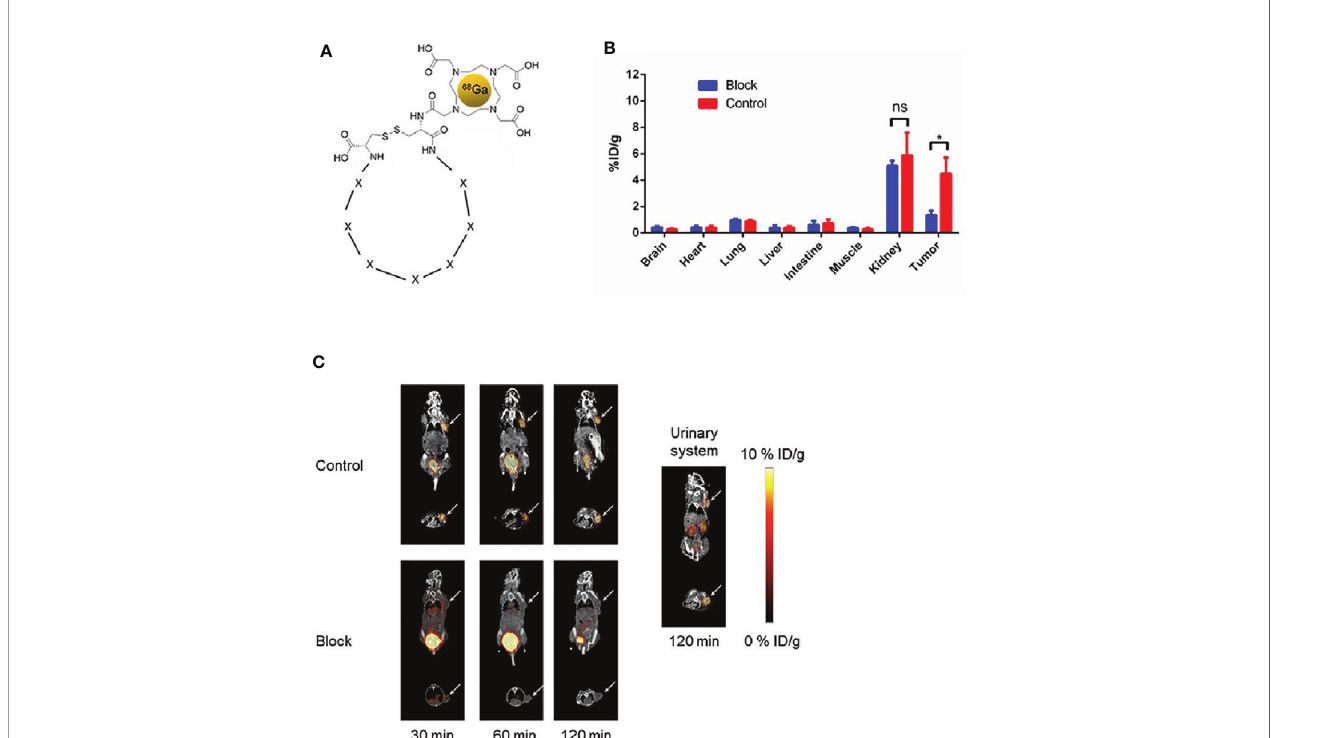
FIGURE 5 | Micro-PET/CT imaging of 68 Ga-DOTA-F3 targeting HepG-2 tumor in vivo . (A) Chemical structure of 68 Ga-DOTA-F3. F3 peptide containing 7 amino acids (represent as X) restricted in two cystine was modi fi ed with DOTA at the N-terminus. (B) Quanti fi cation of ROIs in HepG-2 xenografted mice after injection for 60 min presented as %ID/g. The uptake of 68 Ga-DOTA-F3 could be suf fi ciently blocked by pre-injection of DOTA-F3 without radiation (n= 3 per group, p = 0.0121 in tumors of two groups, *p < 0.05, two-tailed Student ’ s t-test) (n= 3 per group, p = 0.4708 in kidneys of two groups, ns, not statistically signi fi cant, two-tailed Student ’ s t-test). All data represent the means ± standard error. P-value was calculated by two-tailed Student ’ s t-test. (C) The whole-body coronal micro-PET/CT images of HepG-2 tumor bearing mice at 30, 60 and 120 min pi. Metabolism of radiotracer by urinary system could be apparently observed at 120 min pi. Tumors are indicated by